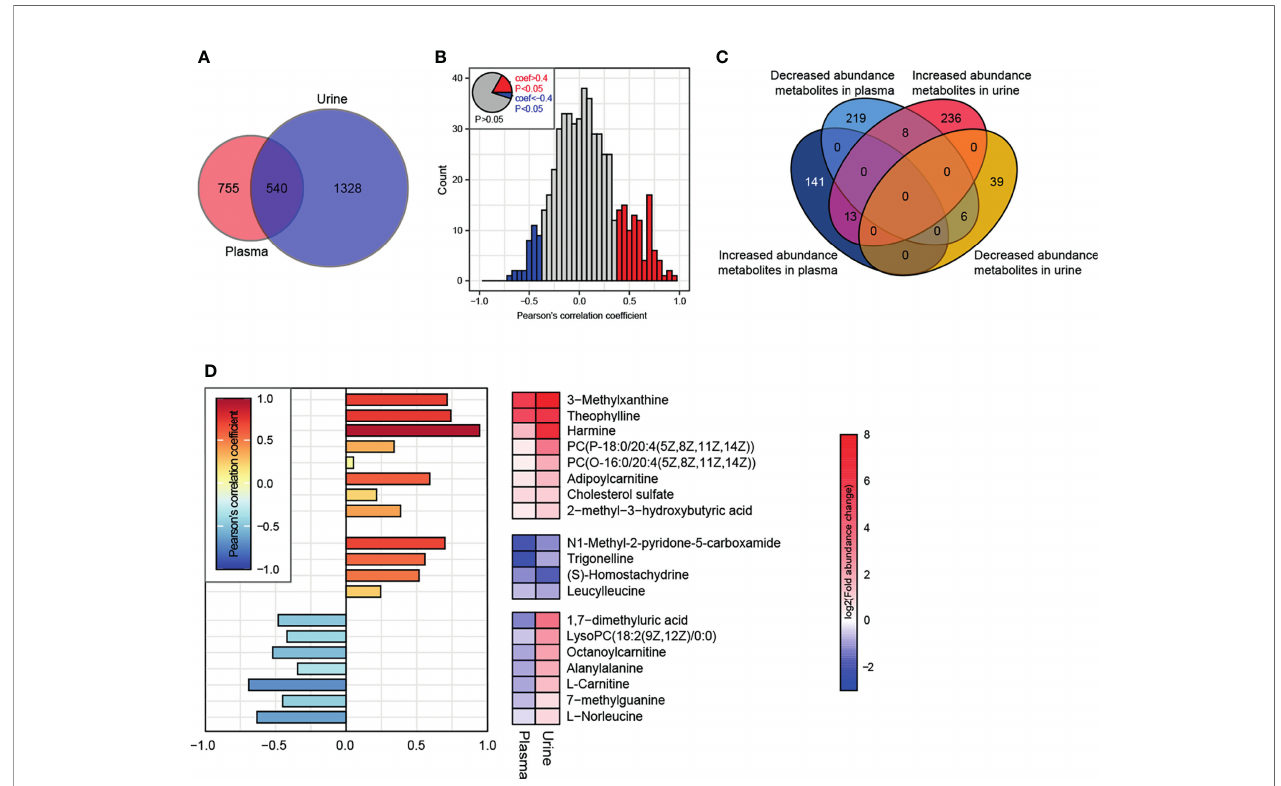
FIGURE 8 | Conjoint analysis of plasma-urine metabolomics. (A) A total of 1295 and 1868 metabolites (containing endogenous and exogenous metabolites and including those without attribution information of chemical taxonomy) were identi fi ed in plasma and urine, respectively. (B) Correlation analysis of metabolites in plasma and urine. Metabolites satisfying P <0.05 and Pearson ’ s correlation coef fi cient>0.4 or < − 0.4 are marked as red and blue, respectively. (C) Characteristics of abundance variation in plasma/urine of all metabolites from (B) . (D) The speci fi c characteristics of abundance variation in each body fl uid of 19 endogenous metabolites extracted from the intersection are shown in (C) . There were 8 exogenous metabolites whose characteristics are not